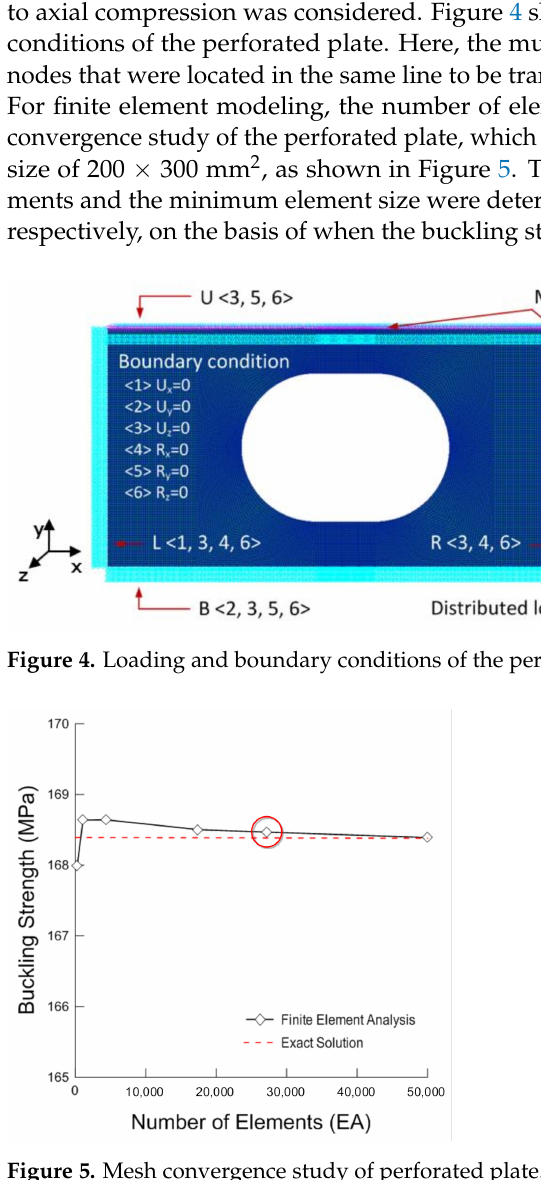
Figure 5. Mesh convergence study of perforated plate.